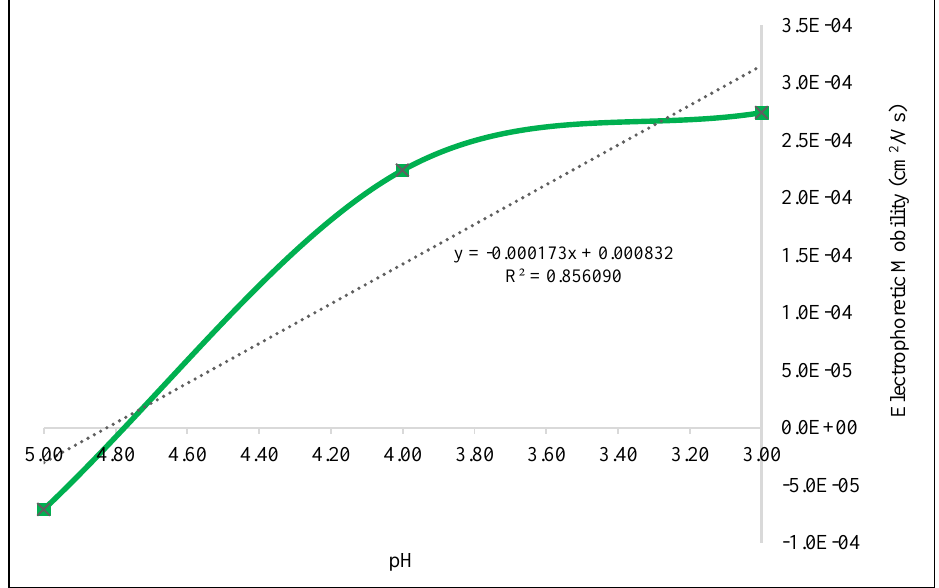
Figure 3. Graph of relationship between electrophoretic mobility value and pH of precipitation on green bean Calculation of Isoelectric pH (pI) of Red Bean